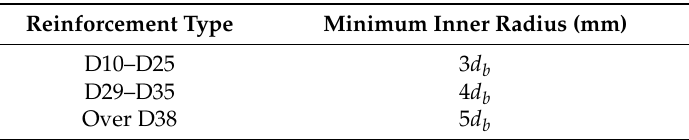
Table 2. Minimum inner radius of reinforcement bending (Code 2010).